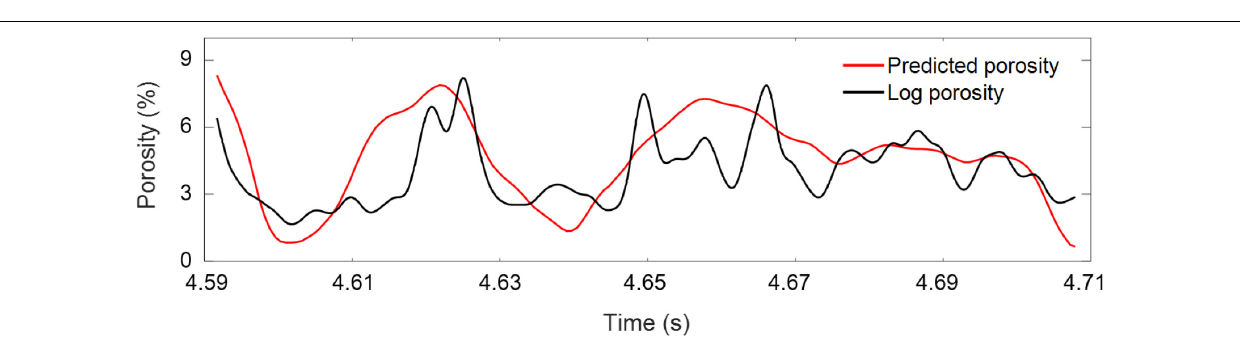
FIGURE 13 | Comparison between the predicted total porosity and log porosity of well